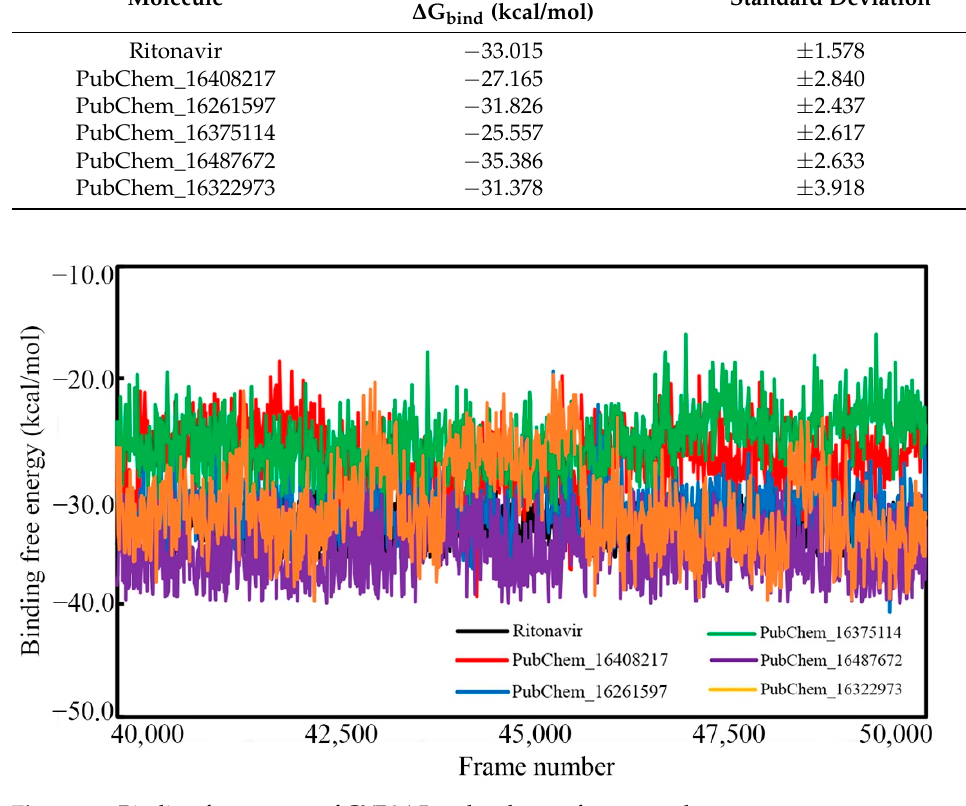
Table 5. The binding free energy of CYP3A5 molecules through MM-GBSA approach. Molecule Ritonavir − 33.015